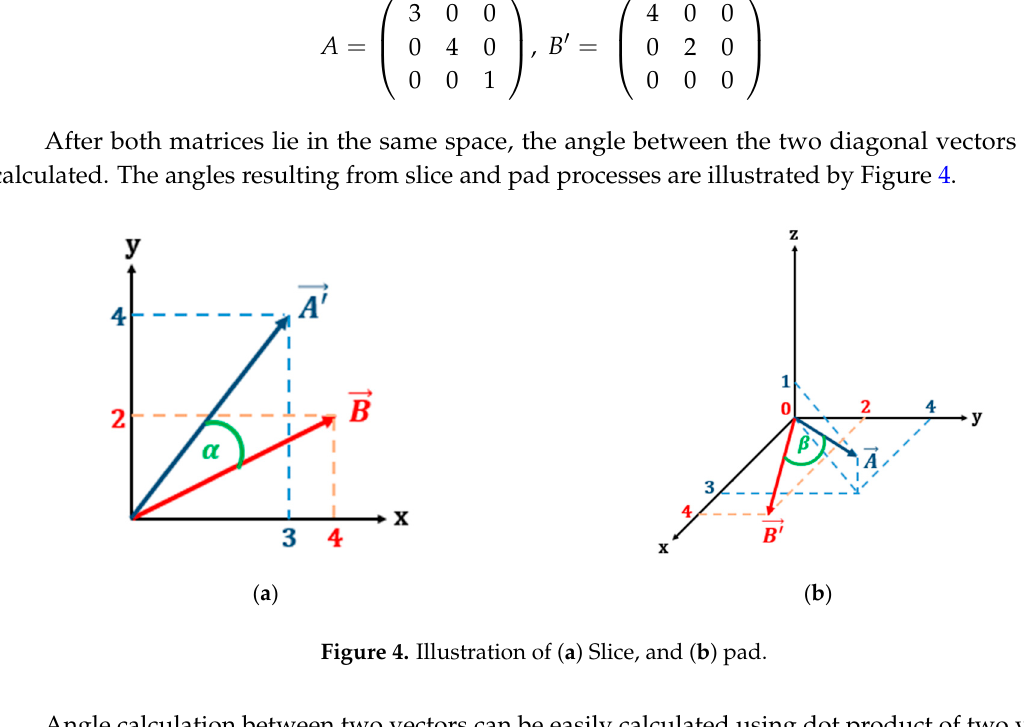
Algorithm 1 Learning Vector Quantization Algorithm